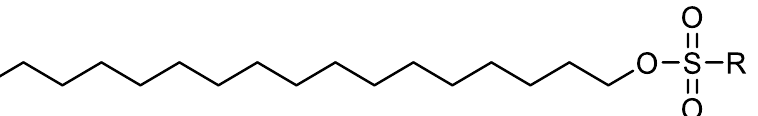
Figure 7. Alkyl sulphonate is an example of a wax dispersant; the R group is typically an aryl or an alkyl group.